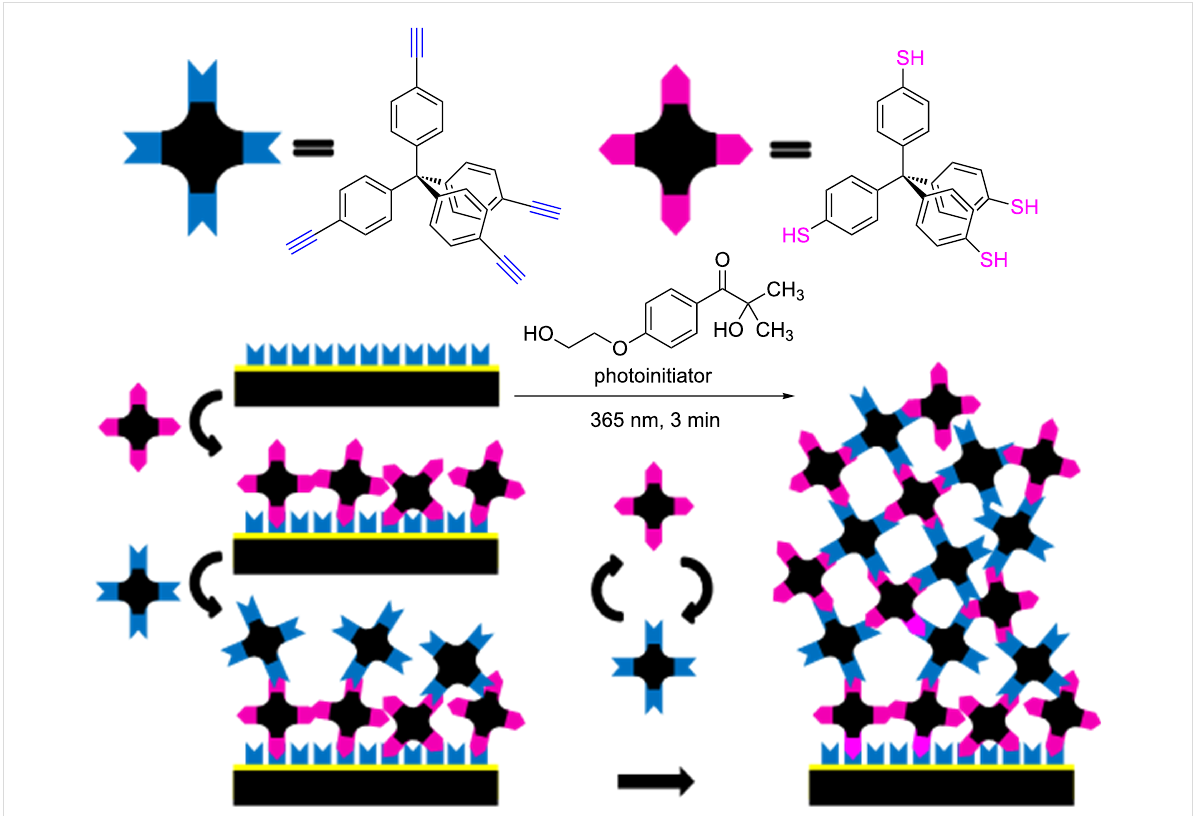
Figure 1: LbL synthesis with TPM-SH and TPM-alkyne using light-induced TYC reaction in the presence of the photoinitiator 2-hydroxy-1-[4-(2- hydroxyethoxy)phenyl]-2-methylpropan-1-one.